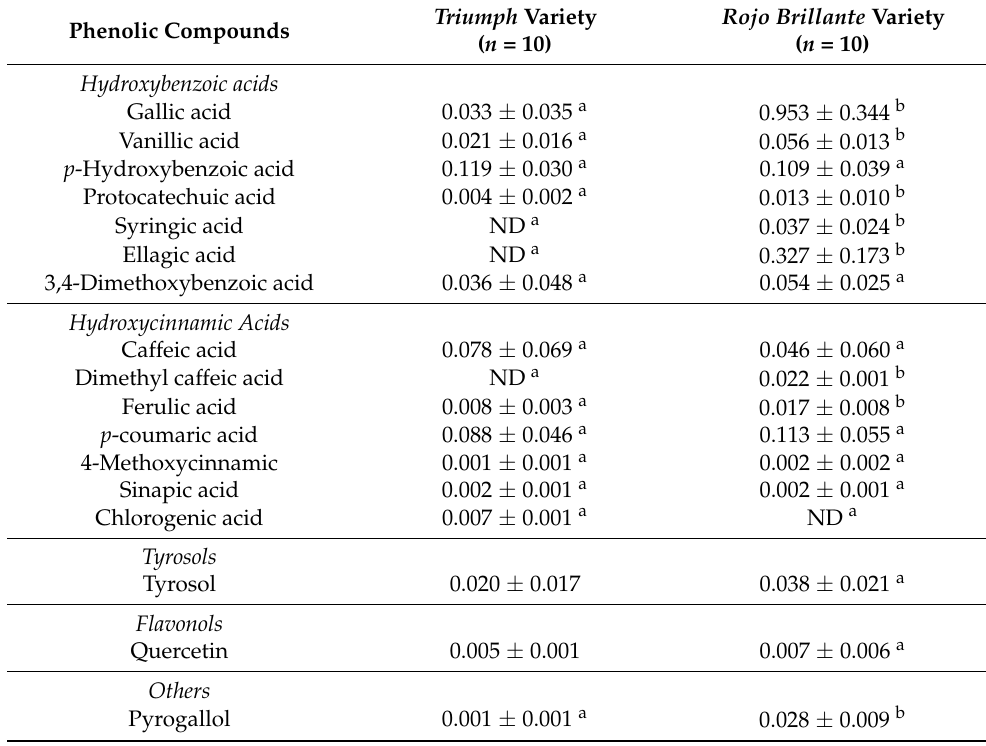
Triumph Variety Rojo Brillante Variety ( n = 10) ( n = 10)